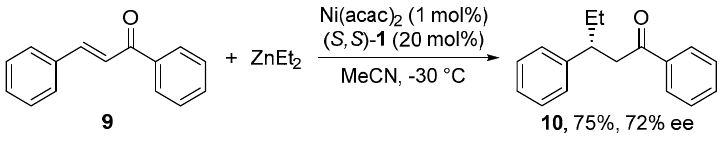
Table 3. Michael addition of β -ketoester 11 to methyl vinyl ketone (MVK) 12 .